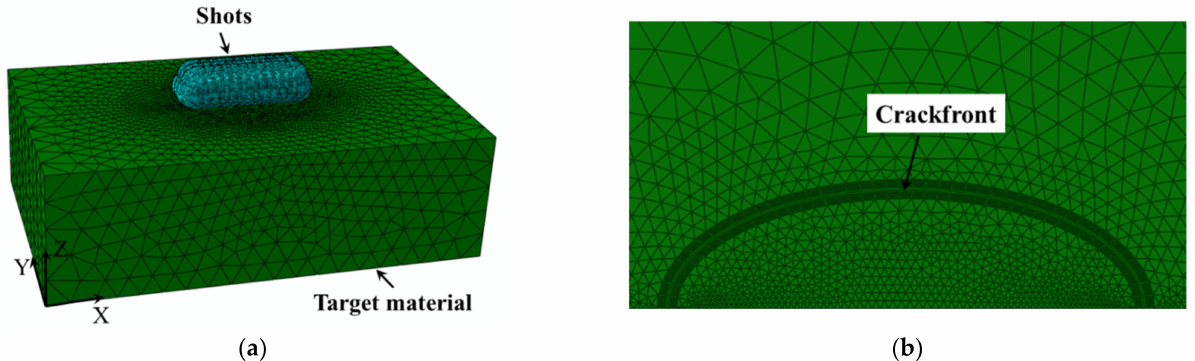
Figure 2. Shot peening finite element model and crack front meshing. ( a ) Shot peening FEM model meshing. ( b ) Crack surface mesh